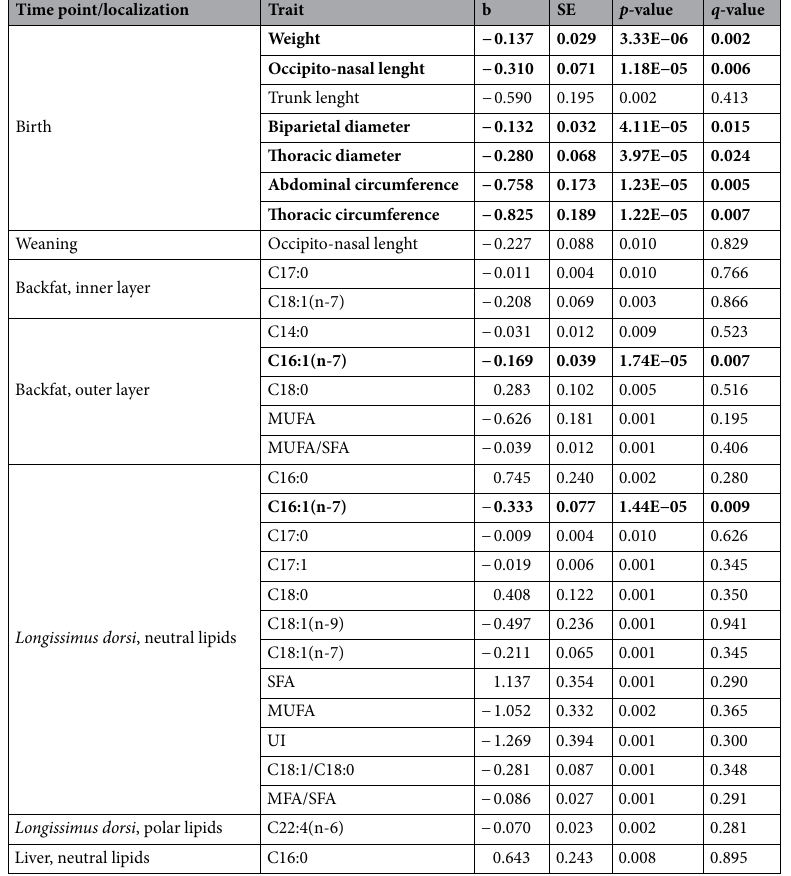
Table 1. Association results for polymorphism located in ACACA gene (75_ ACACA , position 38,825,225). Traits with p‑ value < 0.01 are shown and those with q < 0.10 are highlighted in